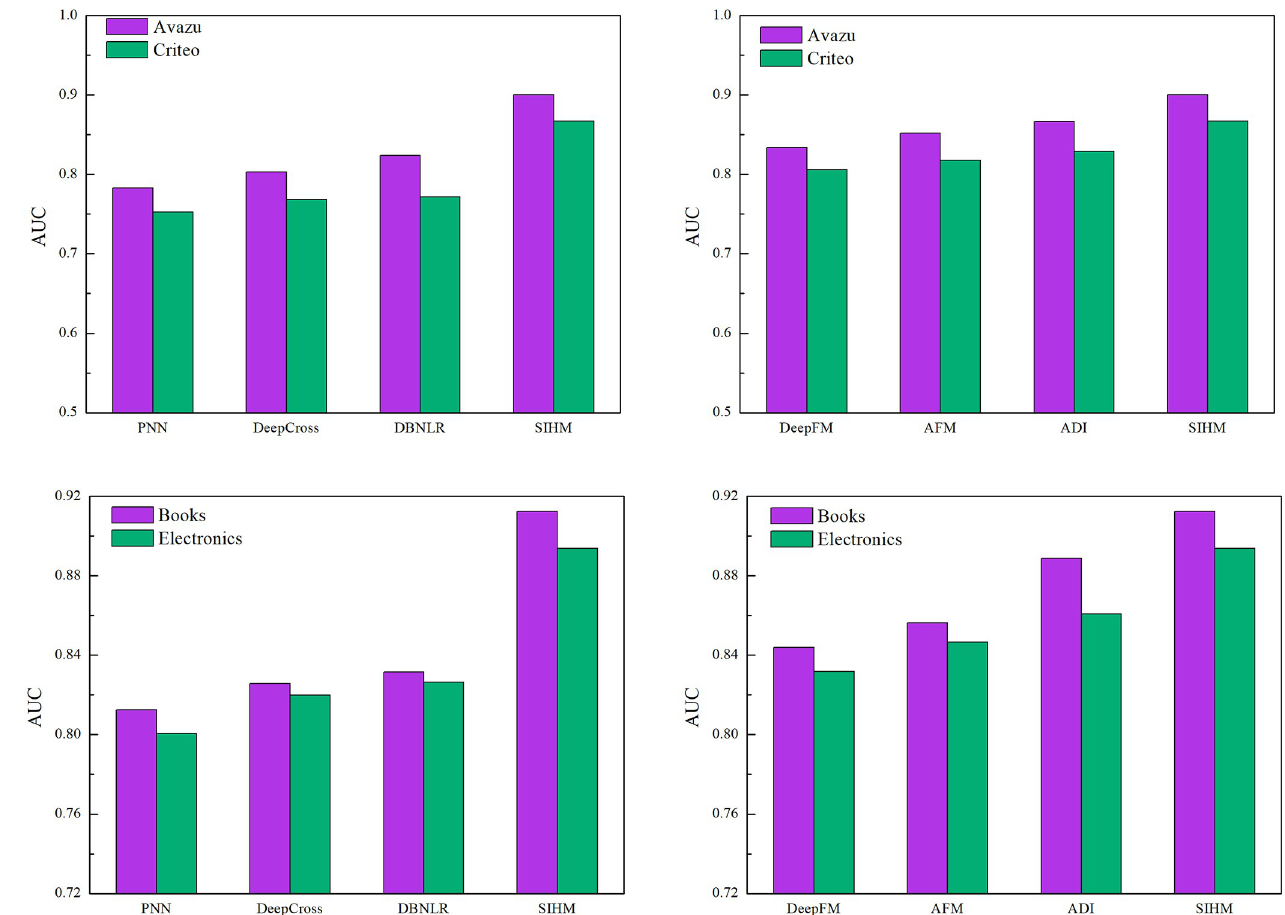
Fig 3. 3-1 AUC performance comparison with other model. 3-2 AUC performance comparison with other model. 3-3 AUC performance comparison with other model. 3-4 AUC performance comparison with other model.